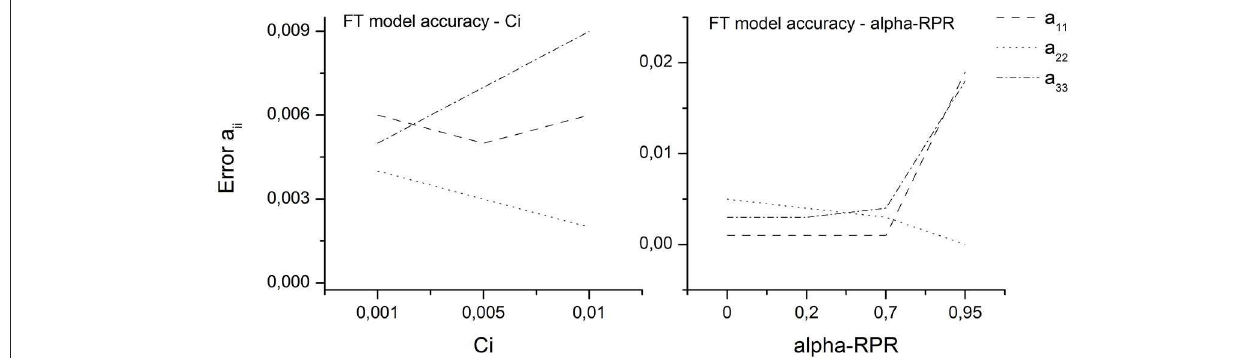
FIGURE 10 | Prediction error of the FT-RPR model.